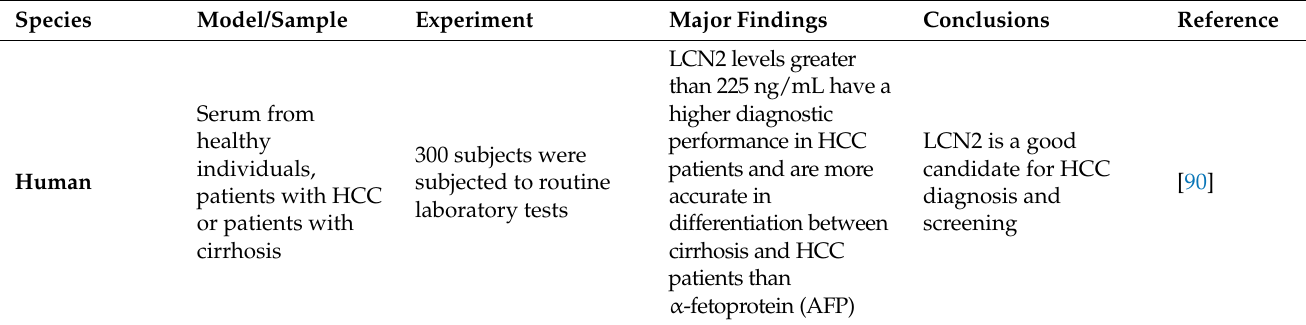
Table 2. Selected experimental and clinical findings associated with LCN2 in hepatocellular carcinoma. Species